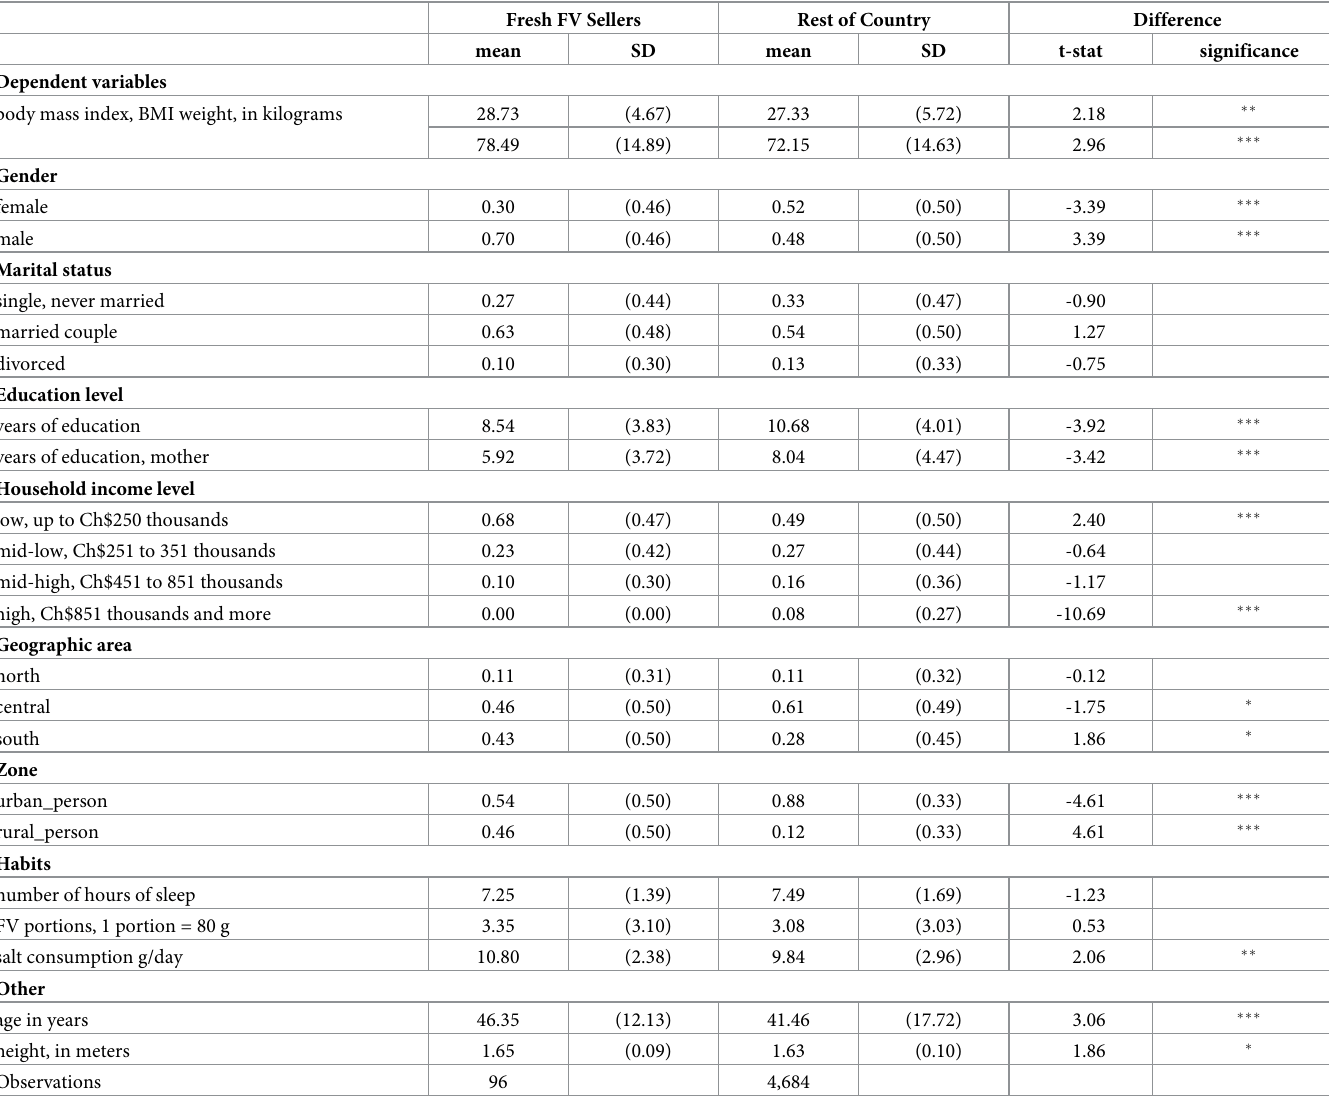
Table 2. Selected variables by